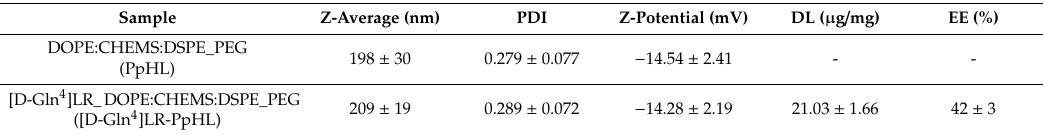
Table 1. Physicochemical characterization of the optimized unloaded and [D-Gln4]LR-loaded liposomes. Each value represents the mean ± SD; PDI: polydispersity index; DL: drug loading; EE: encapsulation efficiency.